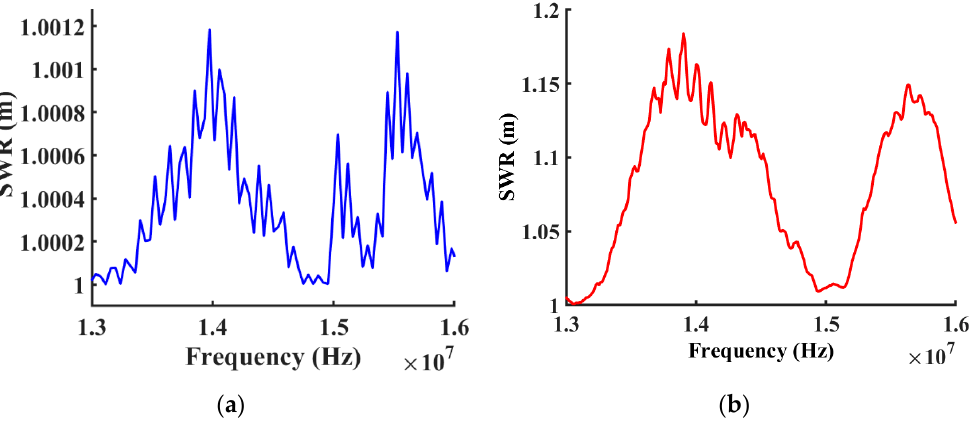
Figure 8. Comparison between simulated (Blue) and measured (Red) standing wave ratios of frequency response for the device with Cr IDTs only, without coatings, from 13 MHz to 16 MHz. ( a ) Simulated standing wave ratios of the design. ( b ) Measured standing wave ratios from the fabricated device.